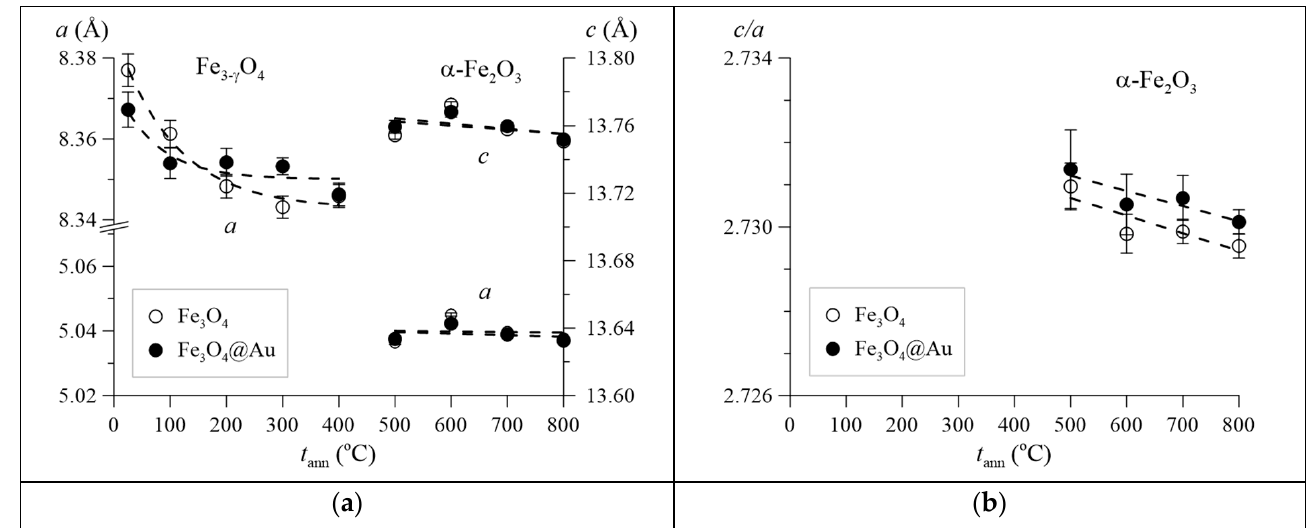
Figure 7. Unit cell parameters for nonstoichiometric magnetite Fe 3- γ O 4 and hematite α -Fe 2 O 3 ( a ), as well as ratios of unit cell parameters a / c of hematite α -Fe 2 O 3 ( b ) depending on the annealing temperature t ann.